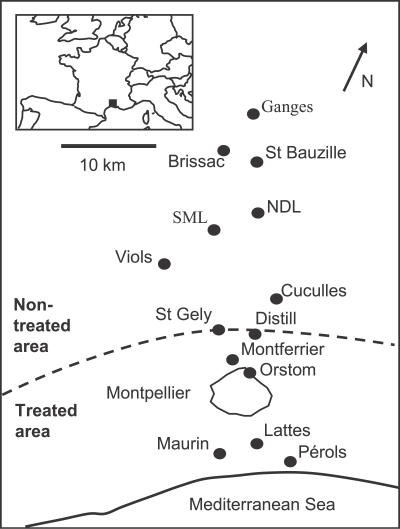
Sample Site Locations in the Northwest Southeast Transect in the Montpellier AreaSamples are indicated with black circles. The dashed line represents approximately the border between treated and untreated areas (modified from [16]). C. pipiens is present in the whole area.